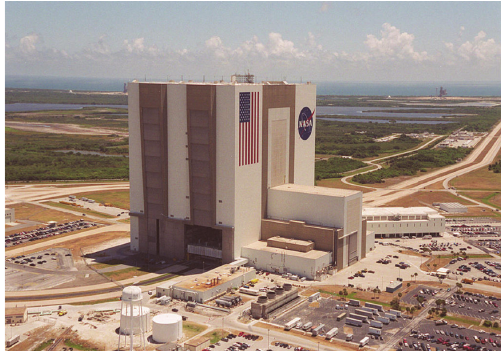
Data processed on the tablet can also be saved into cloud.